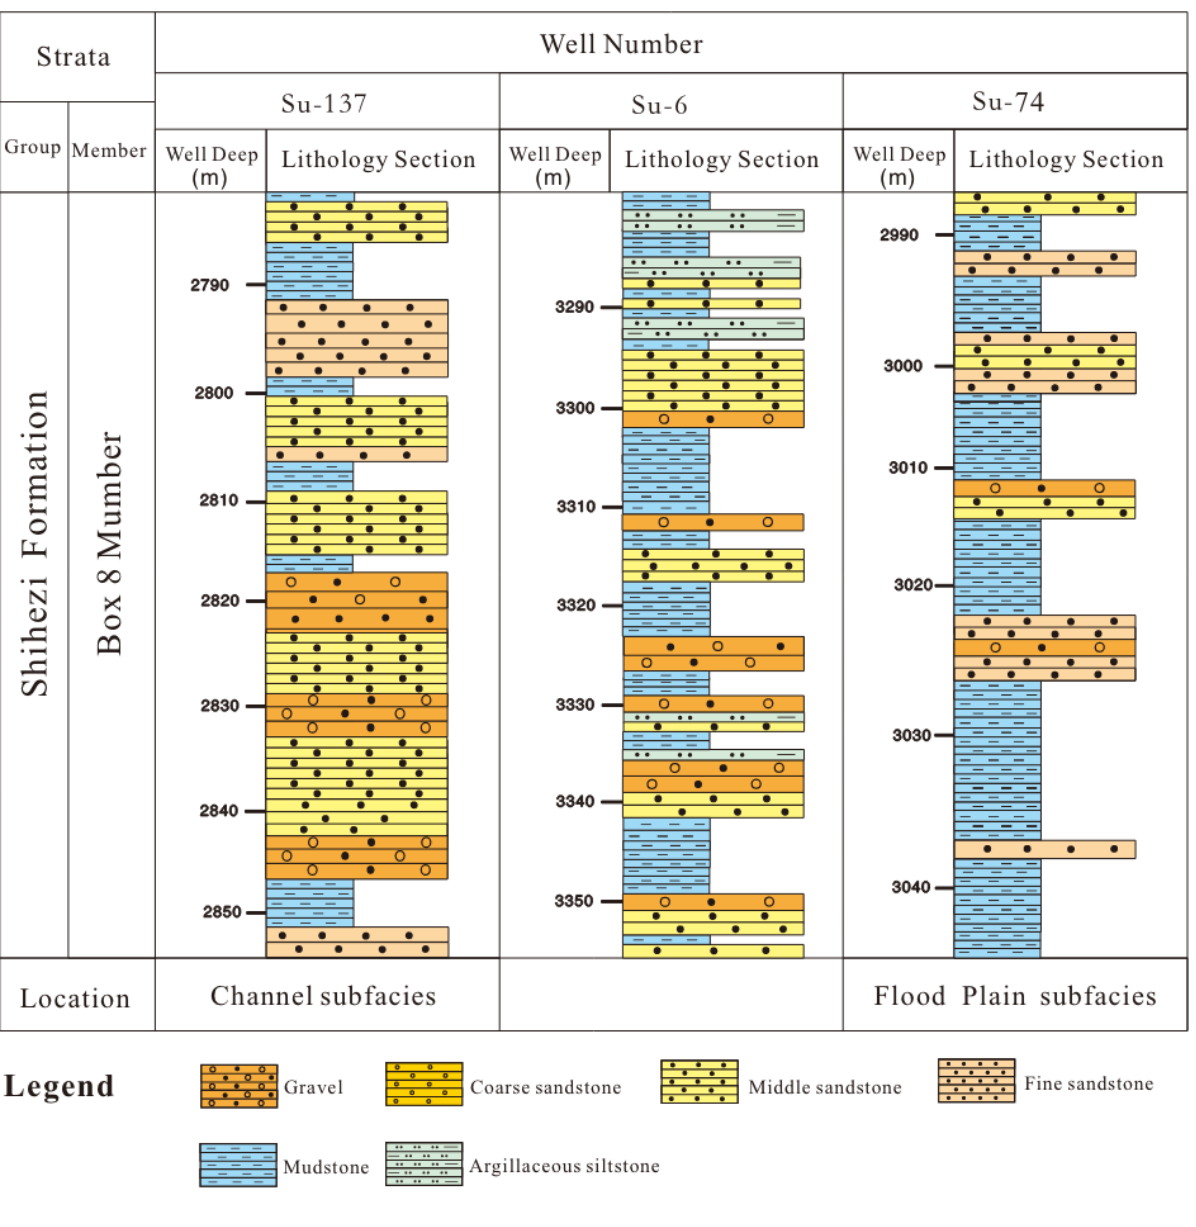
Figure 4. Classification of borehole fluvial facies in core profiles of Sulige gas field (Source domain,